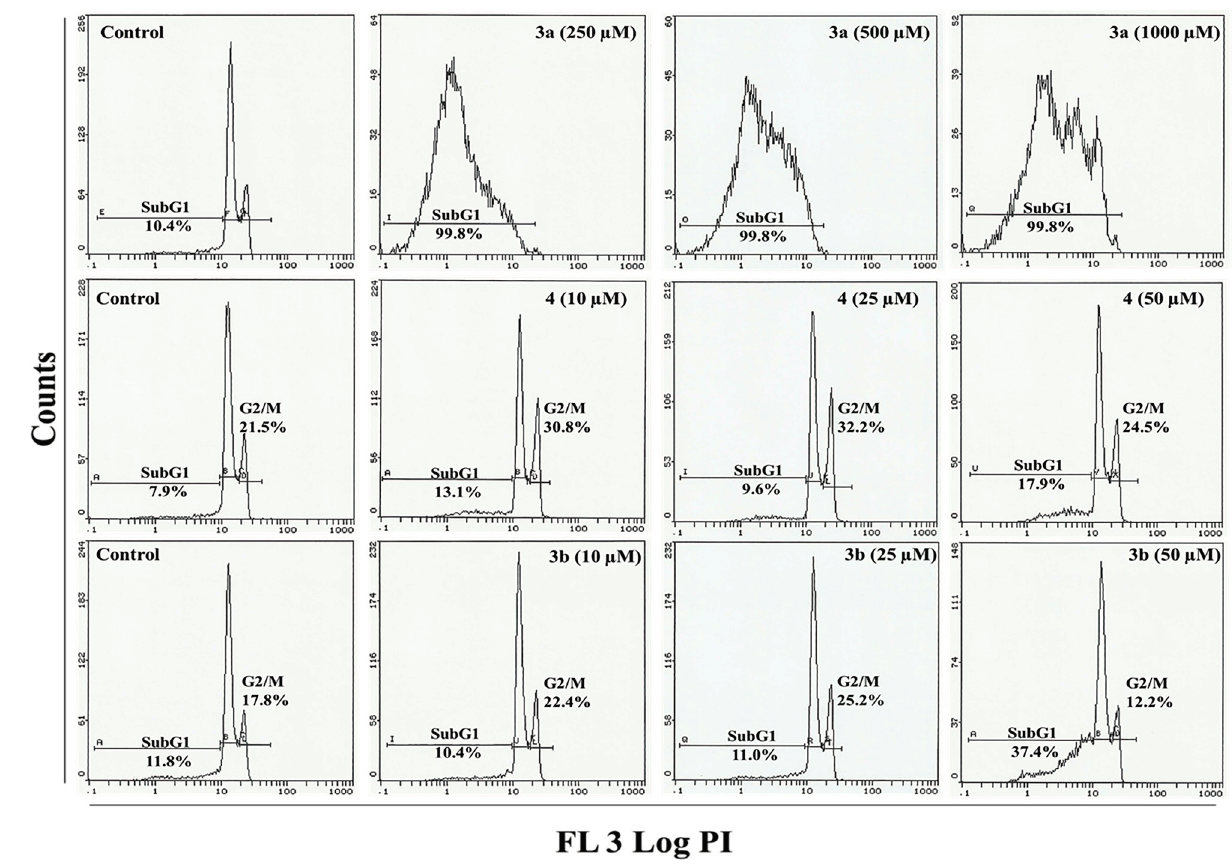
Figure 4. Flow cytometry images of treated HepG2 cells. Flow cytometry images show changes in cell cycle progression in HepG2 cells exposed to compounds 3a , 3b and 4 for 24 h. Sub-G1 indicates the cells undergoing apoptosis/necrosis and G2/M indicates the cell cycle